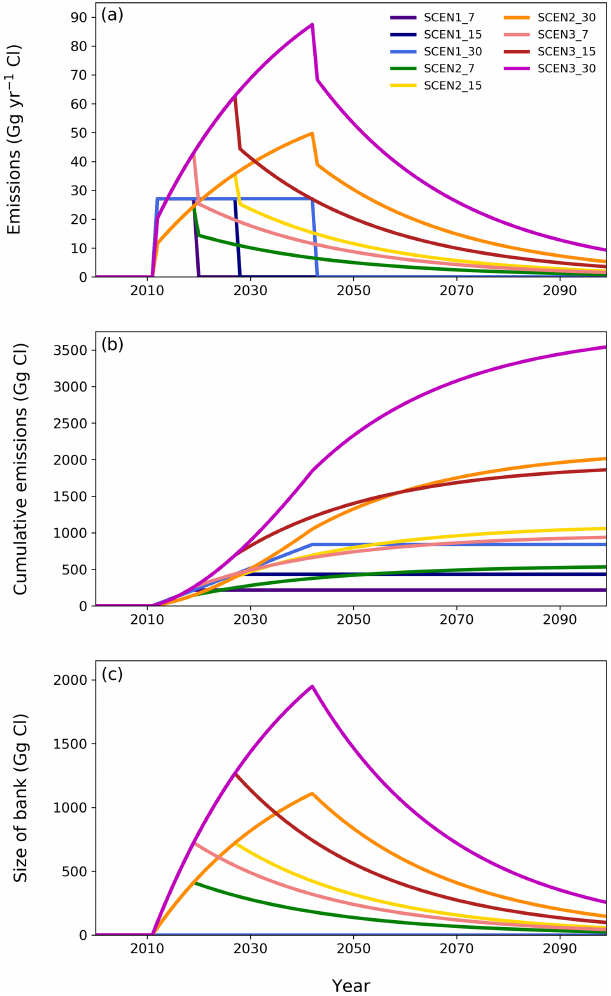
Figure 1. (a) Additional emissions (in GgClyr − 1 ) assumed for each of the SCEN simulations on top of those already assumed by the WMO (2014) A1 scenario. For all scenarios, the additional, un- controlled source of emissions is assumed to start in 2012. (b) Cu- mulative additional emissions for each of the SCEN simulations. (c) The size of the newly created bank for the SCEN2 and SCEN3